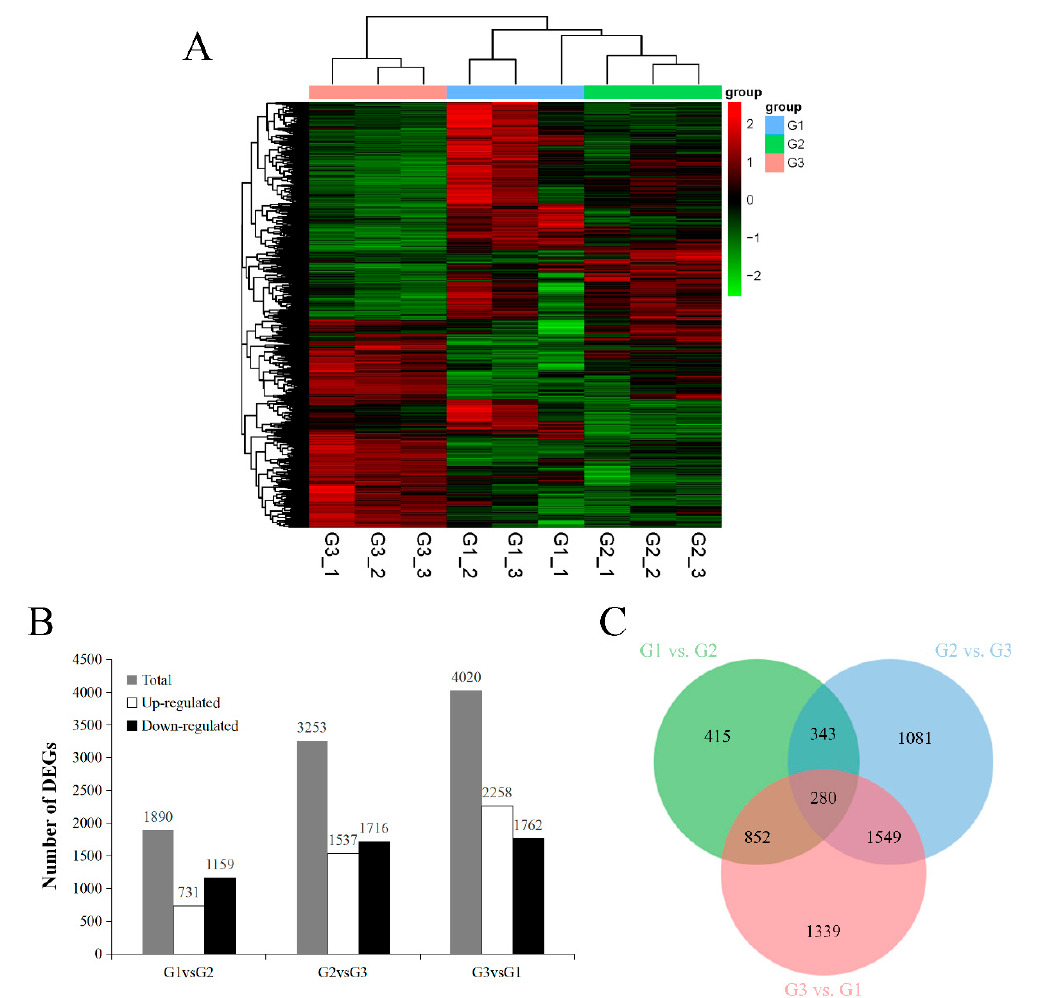
Figure 1. Analysis of differential gene expression in walnut seed kernel at different developmental stages. ( A ) Heatmap and clustering analysis of expression levels of DEGs. ( B ) Up-regulated and down-regulated the amount of DEGs. ( C ) The Venn diagram of DEGs.